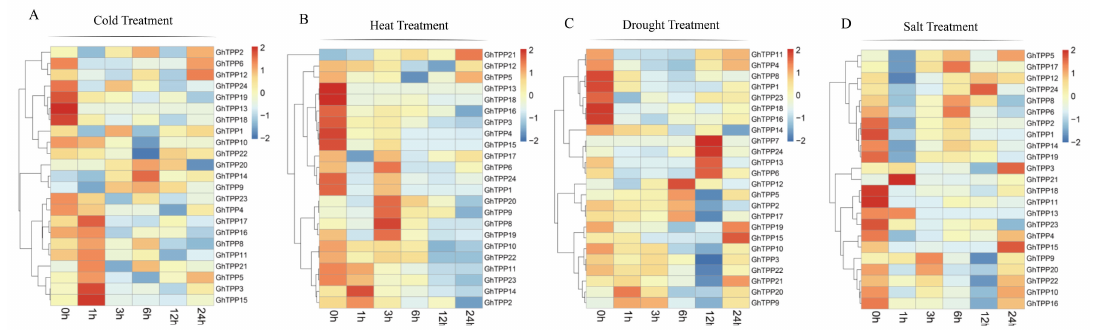
Figure 7. Expression profiles of TPP genes in G. hirsutum under different stress treatments. The transcriptomic data were normalized via log2 (FPKM+1) to generate a heatmap. Shown from left to right are the data under cold ( A ), heat ( B ), drought ( C ), and salt ( D ) stress are shown from left to